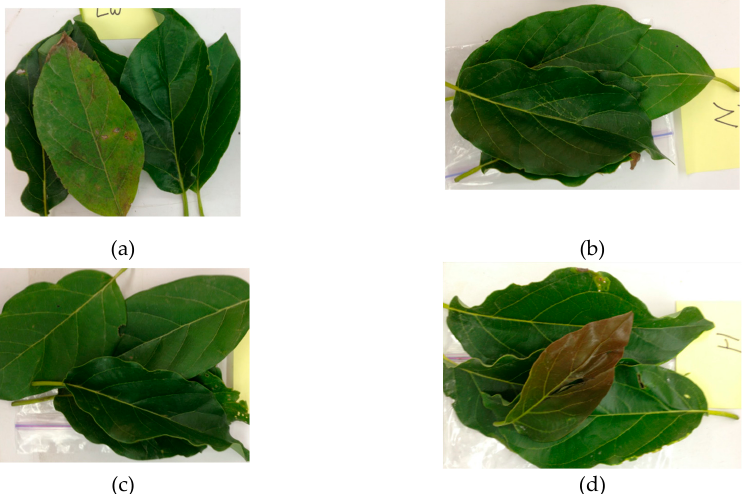
Figure 1. Examples of leaves at di ff erent early stress stages: ( a ) Laurel wilt (Lw); ( b ) N deficiency; ( c ) Fe deficiency, and ( d ) healthy leaves. Images were taken 14 days after